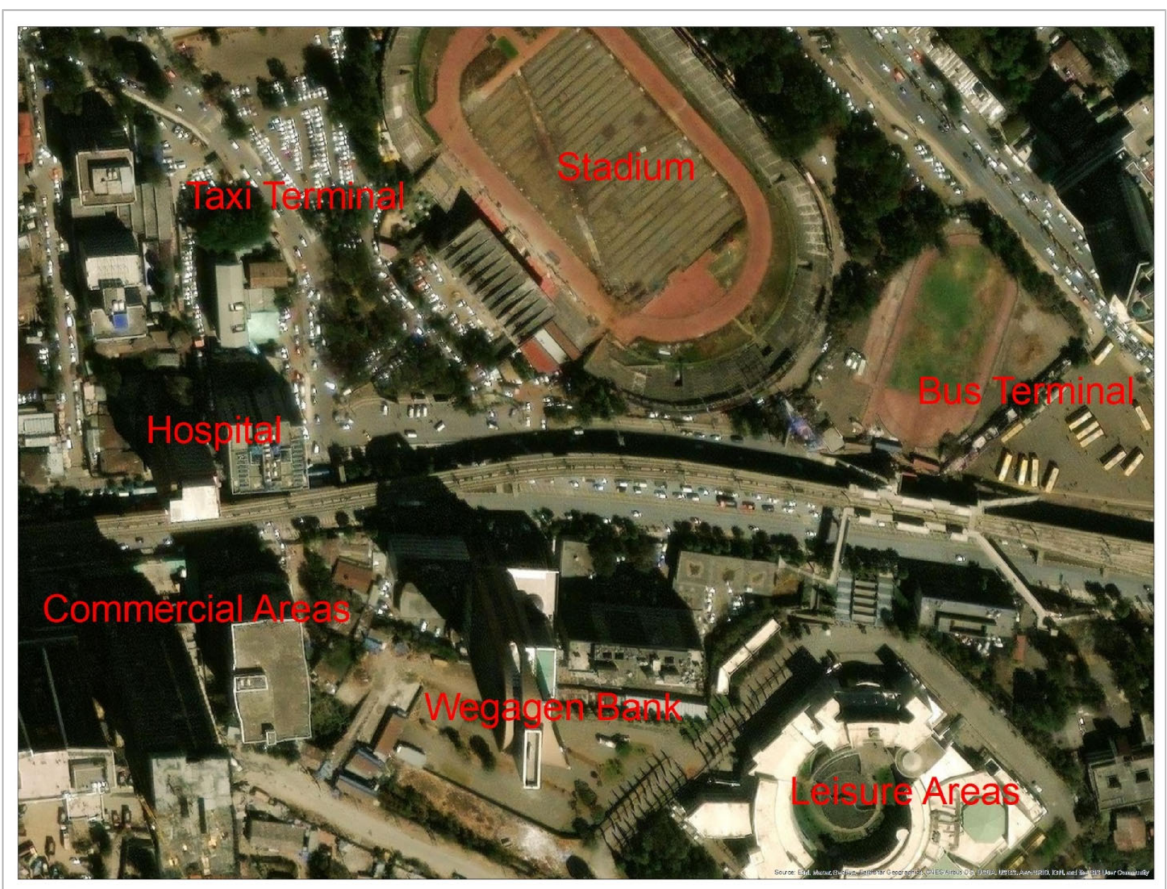
Figure 2. Difference service close to the